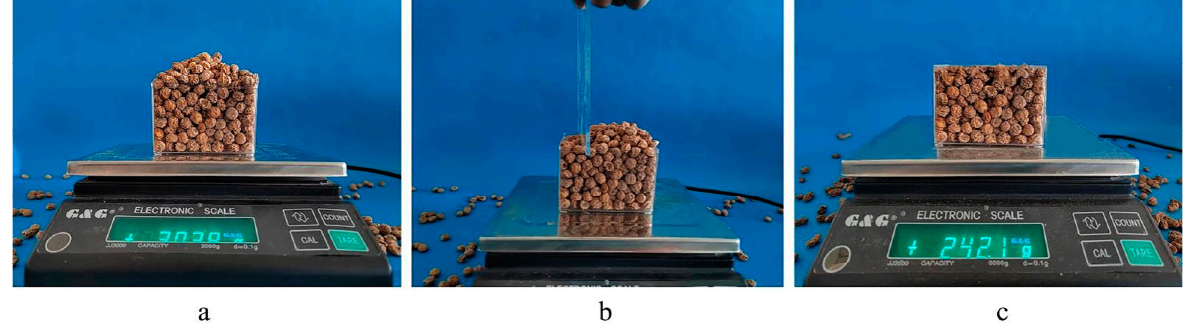
Figure 9. Bulk density test of the Cyperus esculentus seeds [22]. ( a ) particle assembly accumulation; ( b ) use the scratch board to make the surface flat; ( c ) measuring the residual mass of the seeds.